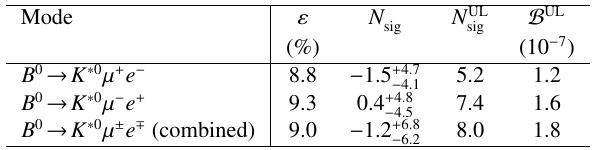
decays B 0 → K ∗ 0 µ + e − , B 0 → K ∗ 0 µ − e + , and also for both